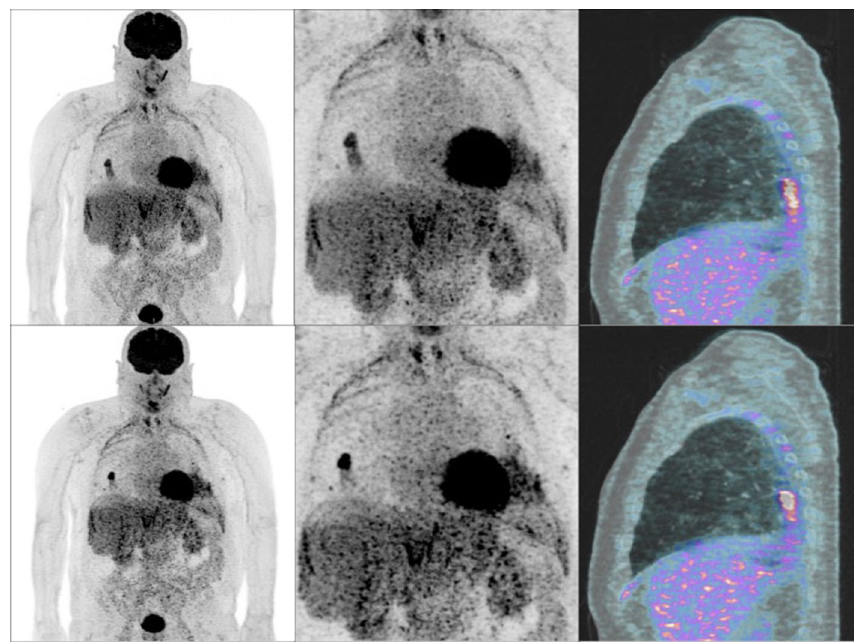
Fig. 1 Free-breathing flow (first row) vs data-driven respiratory gating (second row) 18 F-FDG PET/CT